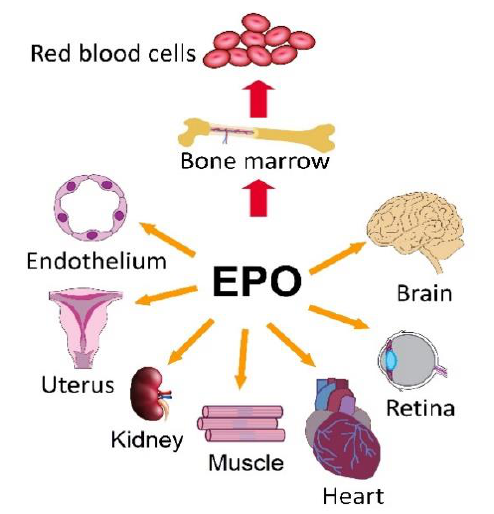
Figure 2. Non-hematopoietic sites of EPO/EPOR. Adapted with permission from ref. [57]. Copyright year 2020, owner’s name Constance T. Noguchi.